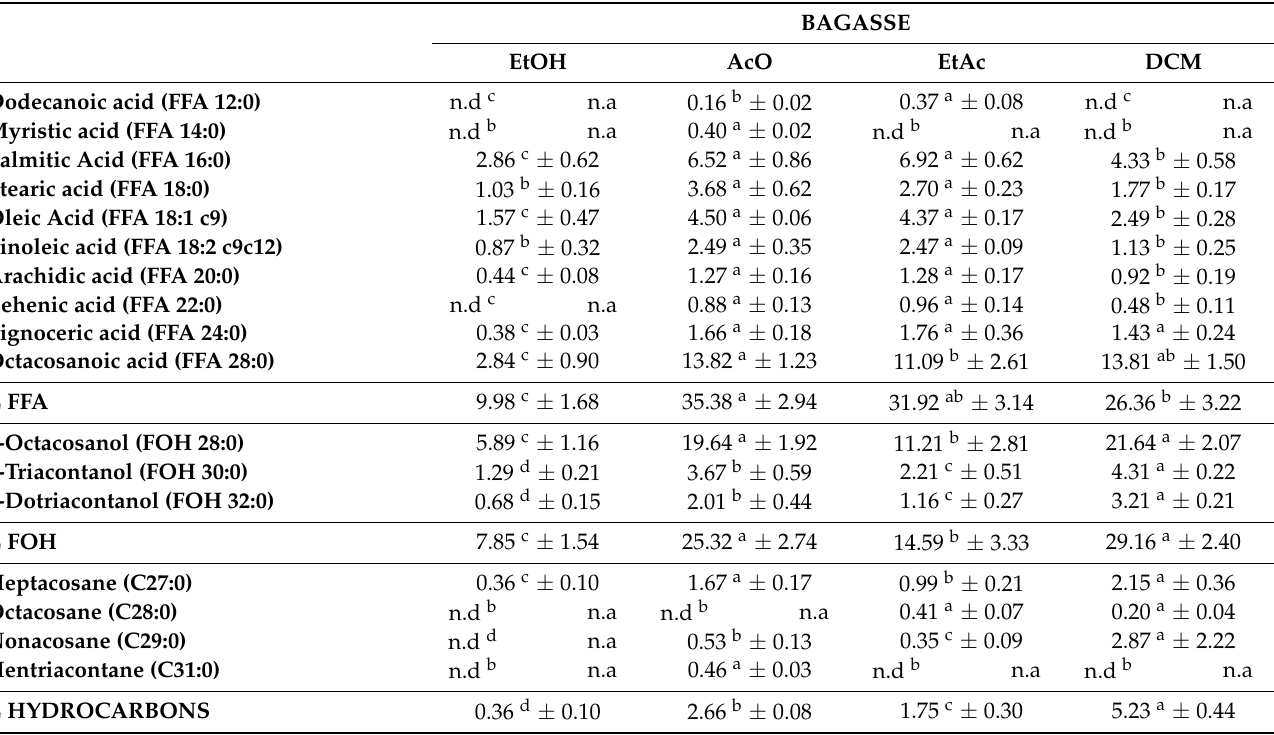
Table 4. Profile (g/kg) in free fatty acids, hydrocarbons, fatty alcohols, sterols, fatty aldehydes and terpenes of different sugarcane bagasse extracts.